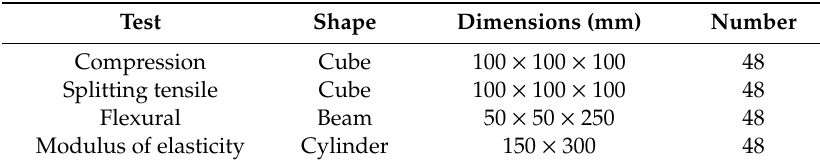
Table 7. Specimens